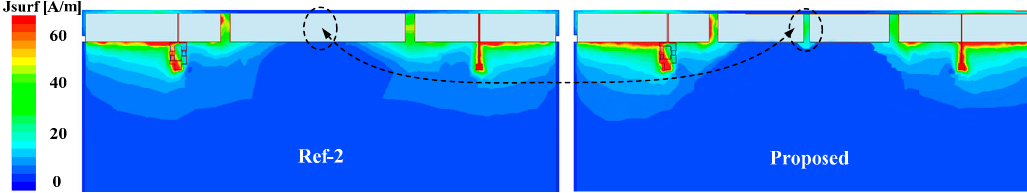
Figure 2. Simulated S parameter of Ant1 for the proposed antenna with and without ( a ) the matching network (Ref-1) and ( b ) the middle shorting strip (Ref-2).